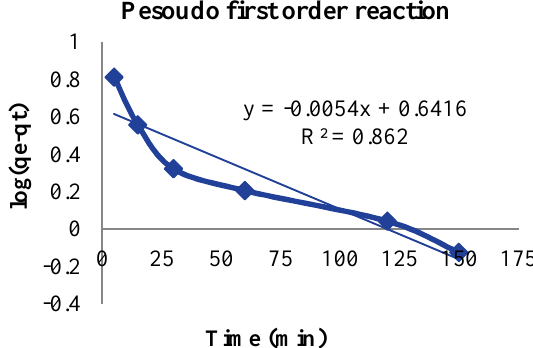
Figure 10. Pseudo-first-order kinetic model of humic acid (HA) absorption on activated carbon (AC) (initial concentration = 25 mg/l, pH = 6-7.5, T = 25 ºC